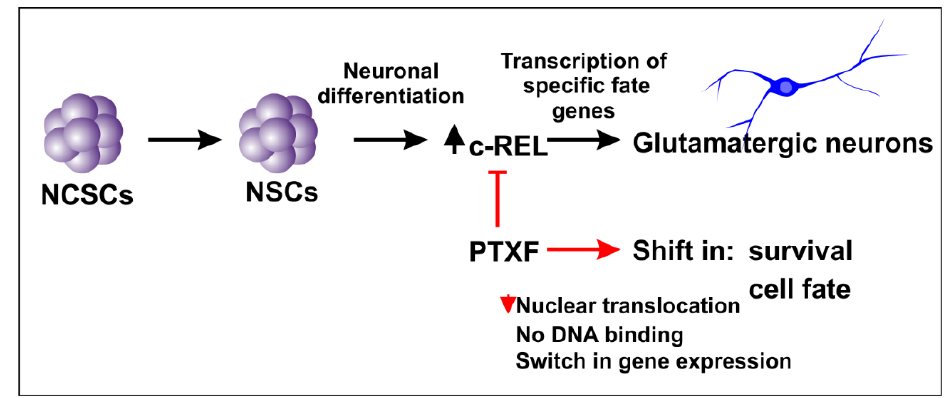
Figure 3. Diagram showing neuronal differentiation of NCSCs and PTXF mechanisms. The nuclear increase of NF- κ B-c-REL directs differentiation into the glutamatergic neuronal fate. c-Rel inhibition by PTXF leads to a switch in the gene expression program from the neuronal fate, resulting in the cell fate shift, cell death or both. PTXF: pentoxifylline, NCSCs: neural crest-derived stem cells, NSCs: neural stem cells.